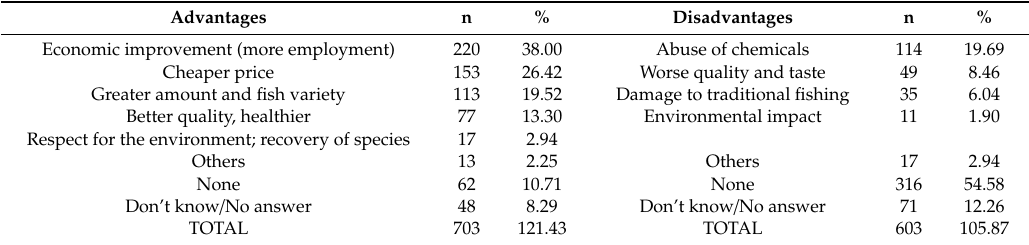
Table 4. Perception of the potential advantages and disadvantages of aquaculture.